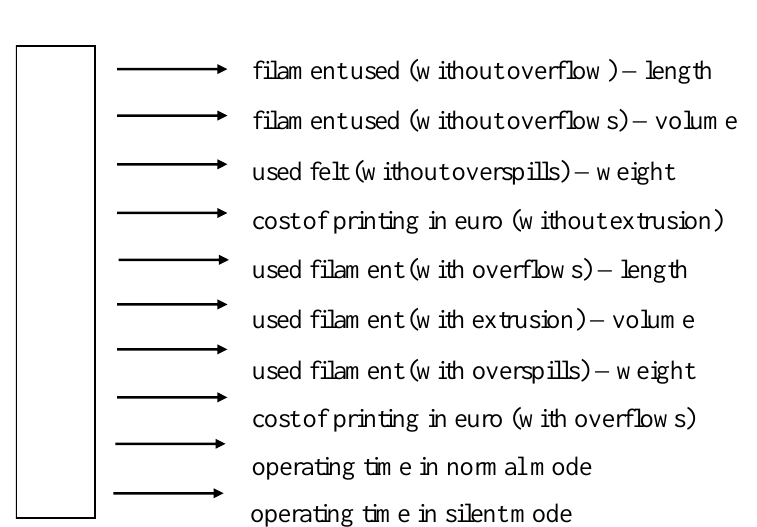
Figure 4. Output parameters of neural network.